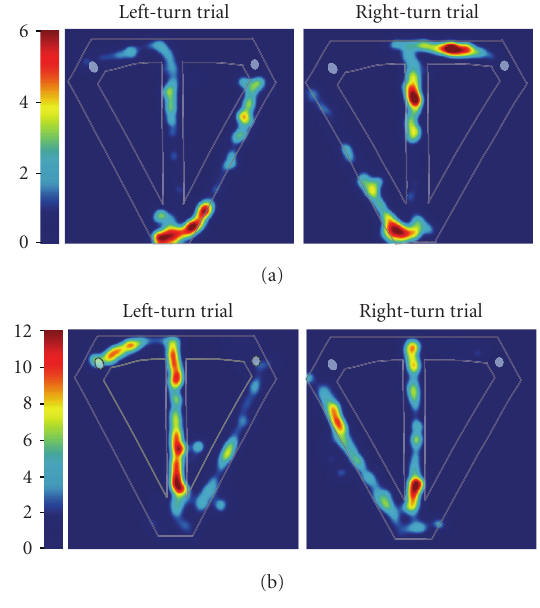
Figure 4: Firing patterns of two representative medial entorhinal neurons that reflect both trial disambiguation and a low degree of spatial specificity. (a). This unit was significantly more active on right-turn trials: significant main e ff ect of segment ( F 6,392 = 11 . 73; P < . 00001), trial type ( F = 7 . 32; P < . 00071) and interaction 1,392 ( F 6,392 = 2 . 22; P < . 04); log-likelihood ratio = 4.62; p correct = 0 . 67; p = 0 . 006. (b). This unit was significantly more active on chance left-turn trials: significant main e ff ect of segment ( F 6,280 = 3 . 83; P < . 0011), trial type ( F = 4 . 87; P < . 03) and interaction 1,280 = 0 . 63; correct ( F 6,280 = 1 . 83; P < . 09); log-likelihood ratio = 1.29; p correct = 0 . 71; p = 0 . 004. Color bars indicate firing rate in chance